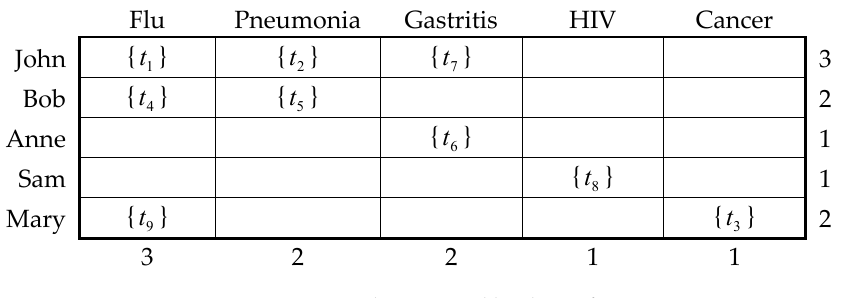
Figure 1. Two-dimensional buckets of T .